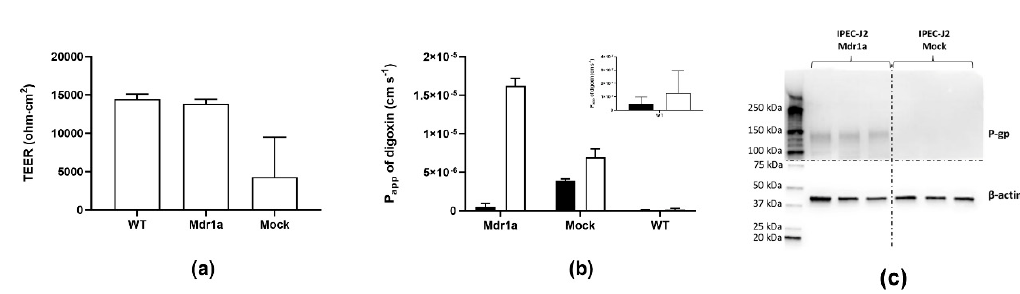
Figure 1. Transendothelial electrical resistance (TEER) measurements, expression of P-glycoprotein (P-gp) in IPEC-J2 rMdr1a monolayers and bidirectional transport of digoxin across IPEC-J2 monolayers. Transport was measured across monolayers formed from IPEC-J2 wild-type cells (WT), mock-transfected IPEC-J2 cells (Mock; transfected with an empty pcDNA vector), and IPEC-J2 cells transfected with rat Mdr1a (Mdr1a). ( a ) TEER was measured across the indicated cell lines after 15–18 days of culture. Measurements were standardized to the area of the permeable support (1.13 cm 2 ). Results are shown as means ± SEM of 3–13 individual passages with 6 − 18 individual permeable supports per passage ( n = 3–13, N total = 18–174). ( b ) Bidirectional transport of digoxin across the indicated cell lines was measured, and apparent steady-state permeability (P app ) values were calculated from the steady-state fluxes. The insert shows a magnified scale for digoxin transport across IPEC-J2 WT cells. Filled bars show P A-B values and open bars show P B-A values. Values are given as means ± SEM of 3 − 6 individual passages with 3 individual permeable supports for each passage and transport direction ( n = 3–6, N total = 9–18). ( c ) Western blots of protein lysates (7.8 µ g) from three di ff erent passages ( n = 3) of IPEC-J2 mock and IPEC-J2 Mdr1a cells. The Western blot was cut in two halves (indicated by the horizontal dotted line), which were developed separately.